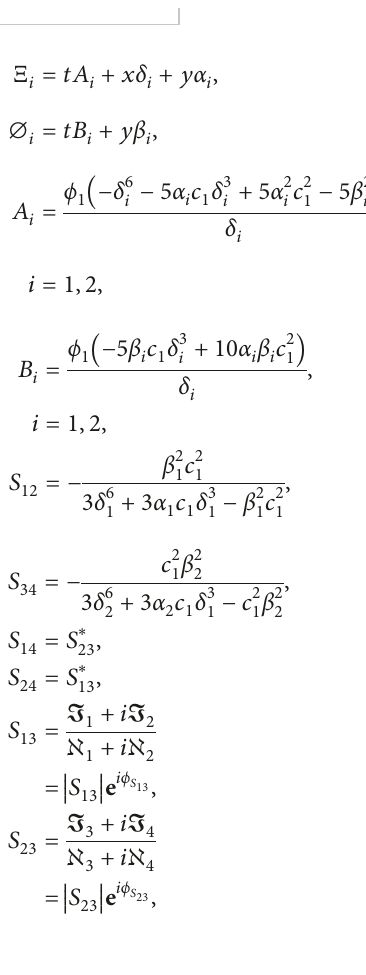
( t ) � 1 , ϕ ( t ) � cos ( t + 3 ) , c 1 9